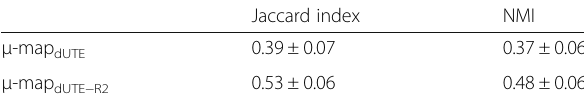
Table 1 Bone overlapping indices: the Jaccard index and NMI between μ -map dUTE and μ -map dUTE − R2 with the pCT